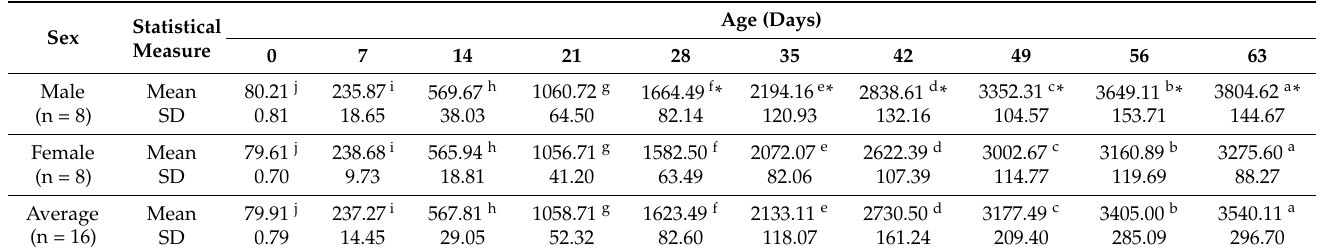
Table 2. Bodyweight (g) of male and female goslings from hatching to 63 d of age 1 .